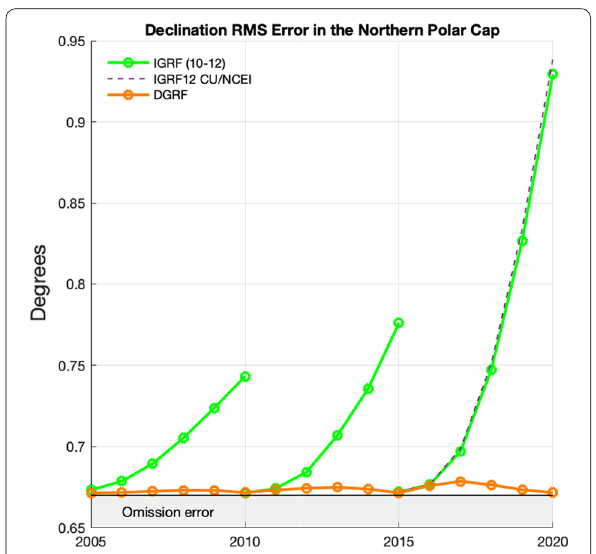
Fig. 6 Estimated declination root-mean-square error in the Northern Polar Cap (latitudes greater than 55 deg., except the area where the horizontal component is smaller than 2000 nT) for recent IGRF SV models (IGRF10, IGRF11 and IGRF12), the most recent DGRF (IGRF13) and the CU/NCEI SV candidate model to